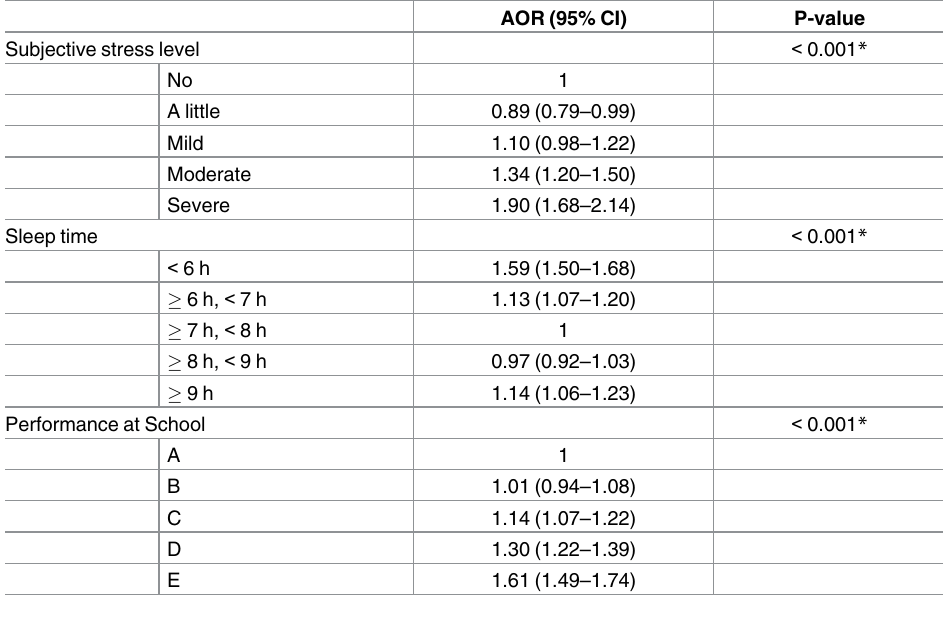
Table 2. Ordinal logistic regression analyseswith complex sampling of subjective stress level, sleep time, and self-assessment of school performance for energy drinks